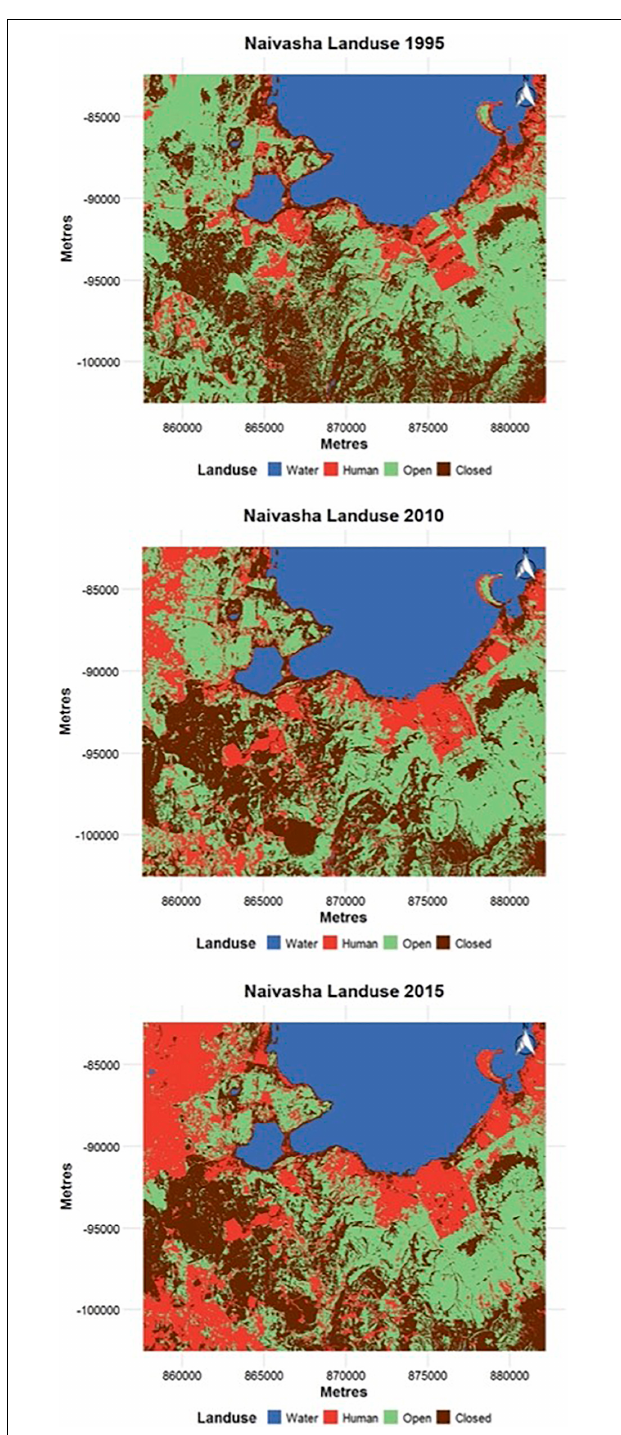
FIGURE 2 | Land use change in the region south of Lake Naivasha from 1995 to 2010. The water class refers to all areas covered by water, the human class refers to all areas covered by human development, agriculture and settlements, the open class refers to savannah and low shrublands, and the closed class refers to forests and dense shrubs and brush. Human development, agriculture and settlements increased by a large degree over the course of the study period, particularly to the west of Lake